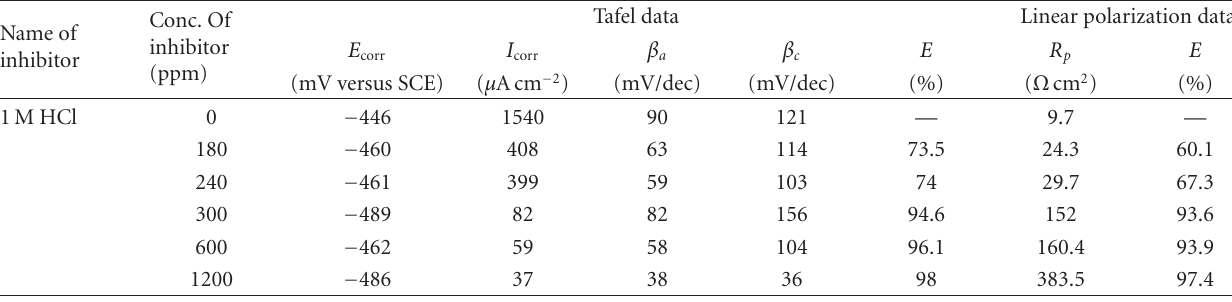
Table 4: Potentiodynamic polarization parameters for mild steel without and with di ff erent concentrations of Kalmegh ( Andrographis paniculata ) extract in 1M HCl.